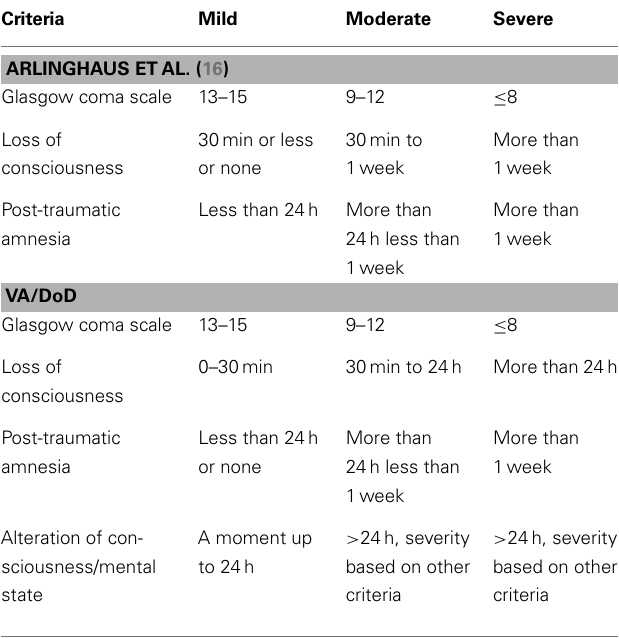
Table 1 | Classification of traumatic brain injury severity.